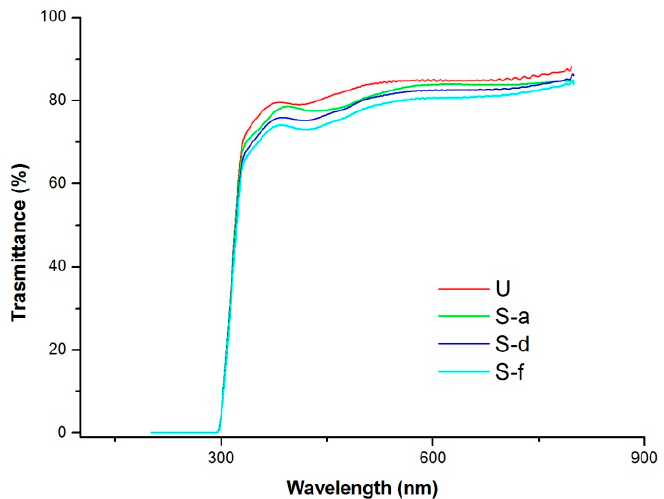
Figure 10. Effect of the reaction conditions on the % transmittance in the UV–visible range of the untreated and some SAM =0treated PET-SiOx films.